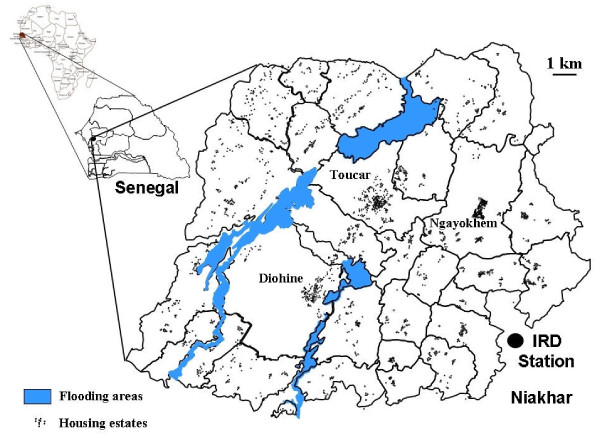
Niakhar study area.